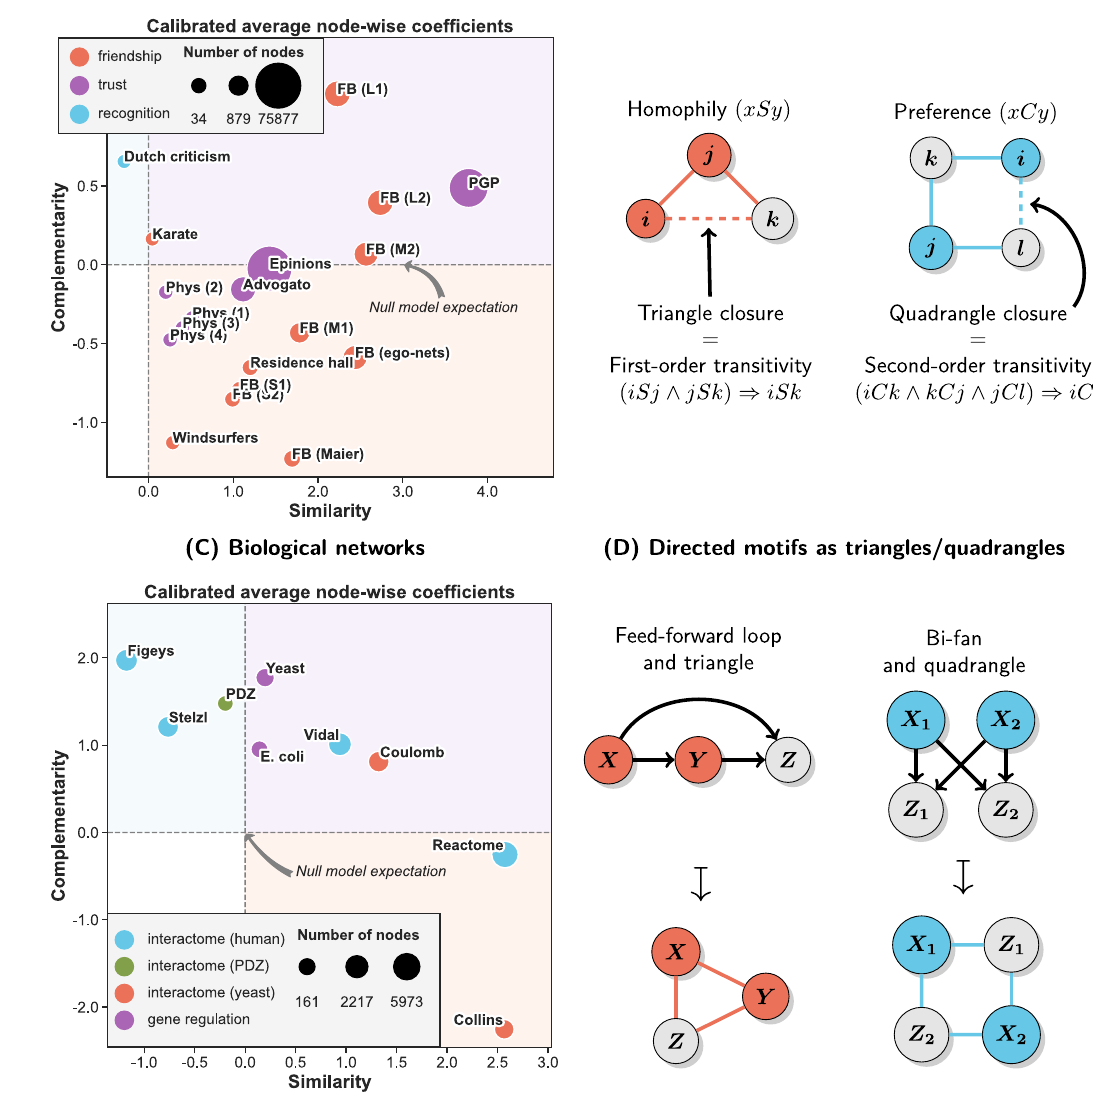
Figure 6. Structural similarity and complementarity in social (19 cases) and biological (9 cases) networks. Scatterplots show calibrated average nodewise coefficients with dashed lines indicating null model expectations based on UBCM (see “Materials and methods” section for details on the datasets and calibration). Colors of the quadrants of the plots indicate configurations of increased values of similarity and complementarity coefficients—high and low (red), low and high (blue), both high (violet). ( A ) Social networks. Almost all feature high similarity and some also increased complementarity (these are mostly large online social networks). The only case with low similarity and relatively high complementarity is the network of Dutch literary criticism representing relationships of recognition (mentioning other’s work, positively or negatively, in an essay or an interview) within a set of notable literary authors 40 . ( B ) Interpretation of similarity and complementarity in terms of homophily, preferences and transitivity. Some social relations, especially those depending on close bonds such as friendship or trust, are often driven by homophily 8,9 . This implies transitivity of ties and the abundance of triangles due to triangle closure. However, other relations such as recognition or skill-based collaboration 23 are based on preferences decoupled from the properties of the ego. In this case two nodes with similar preferences connect to the same neighbors but not necessarily to each other. This leads to what can be called second-order transitivity, which in turn implies quadrangle closure. ( C ) Biological networks. Most of them feature both increased similarity and complementarity indicating higher structural diversity than in the case of social networks. This is consistent with multiple results reporting the abundance of both triangle and quadrangle based motifs 1–3 . ( D ) Examples of the relationship between directed motifs often reported for biological networks and undirected motifs used for defining structural similarity and